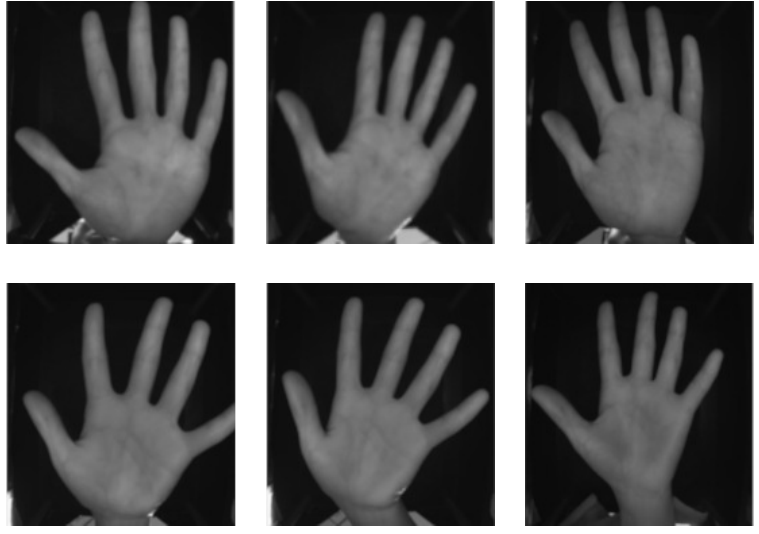
Figure 1. Effects of deformations on different samples of palm vein images from the CASIA Multi-Spectral Palmprint Image Database V1.0